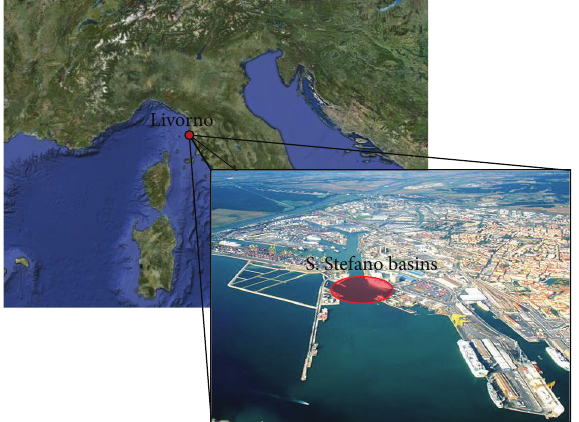
Figure 12: Port of Livorno and in particular S. Stefano basin locations (image from Google